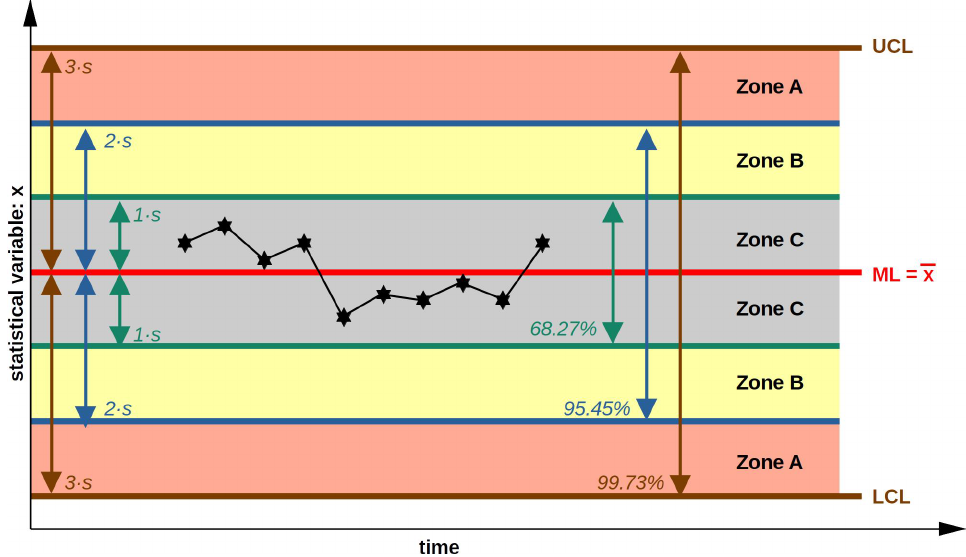
Figure 3. Example of control chart of a statistical variable x , with average ¯ x and standard deviation s